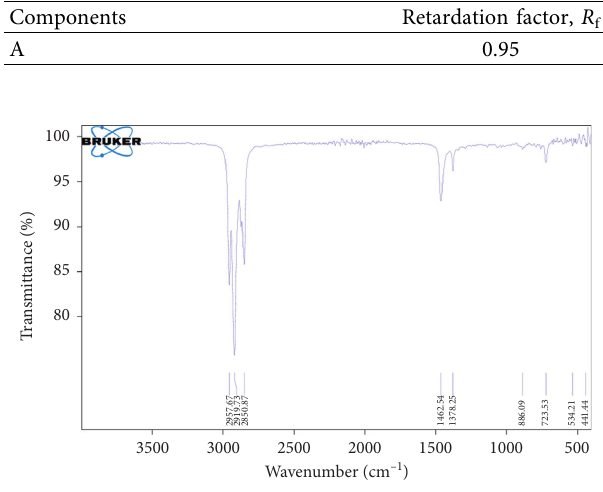
Figure 5: FTIR spectrum of fraction A from the hexane extract of O. basilicum . Table 8: FTIR interpretation of purified fraction A from hexane extract of O. basilicum .